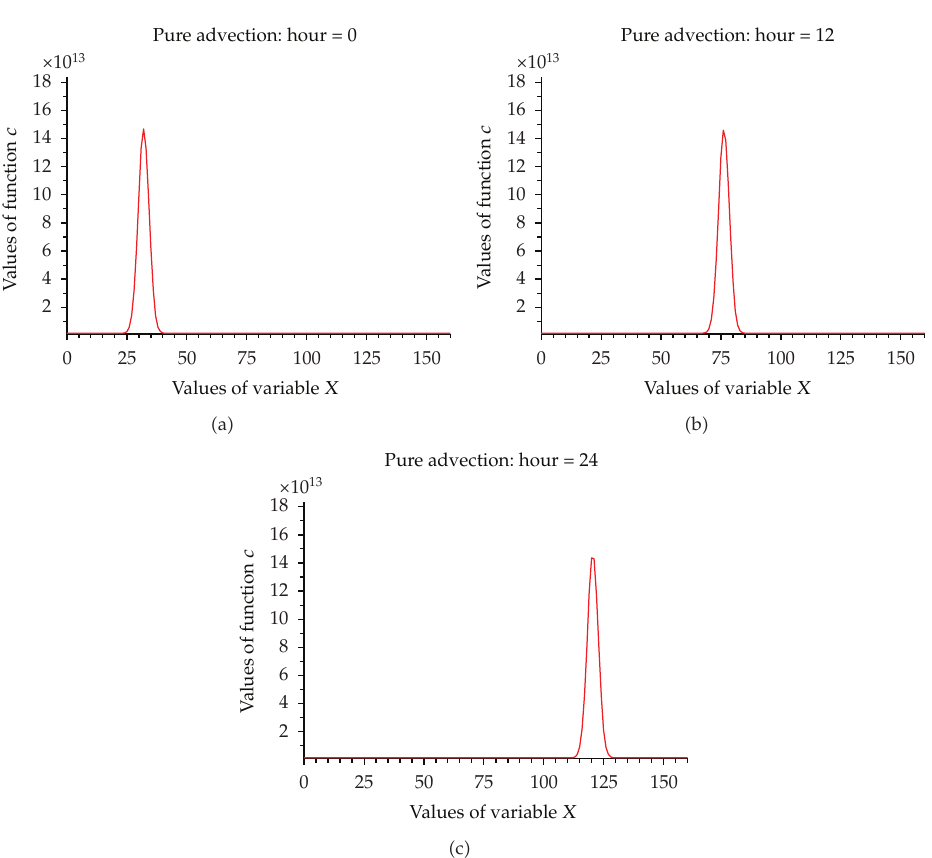
Figure 1: The solution of the one-dimensional advection equation defined in Section 5.2: (cid:6) a (cid:7) at the beginning of the interval (cid:6) the upper plot (cid:7) , (cid:6) b (cid:7) at the end of the twelfth hour (cid:6) the plot in the middle (cid:7) , and (cid:6) c (cid:7) at the end of the time-interval (cid:6) the lower plot (cid:7)